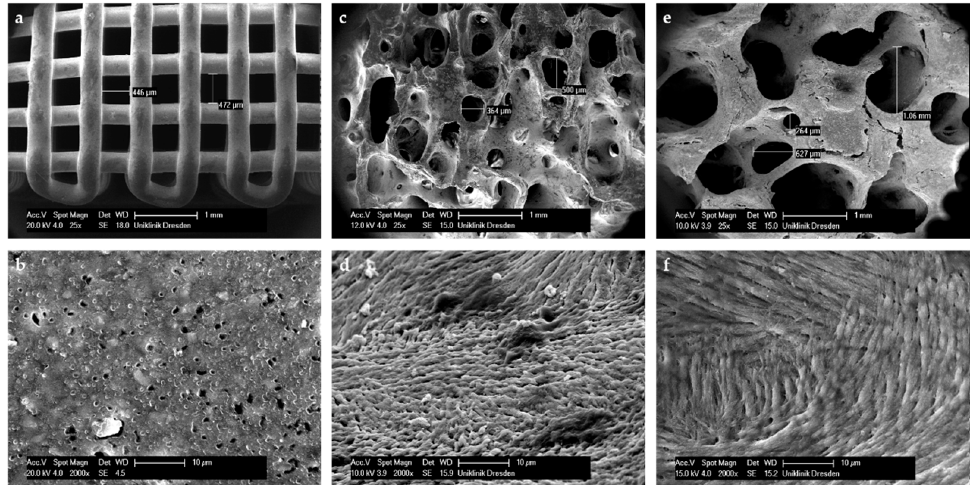
Figure 11. SEM imaging of CPC scaffold D ( a,b ), BioOss ® ( c,d ) and natural bone ( e,f ).